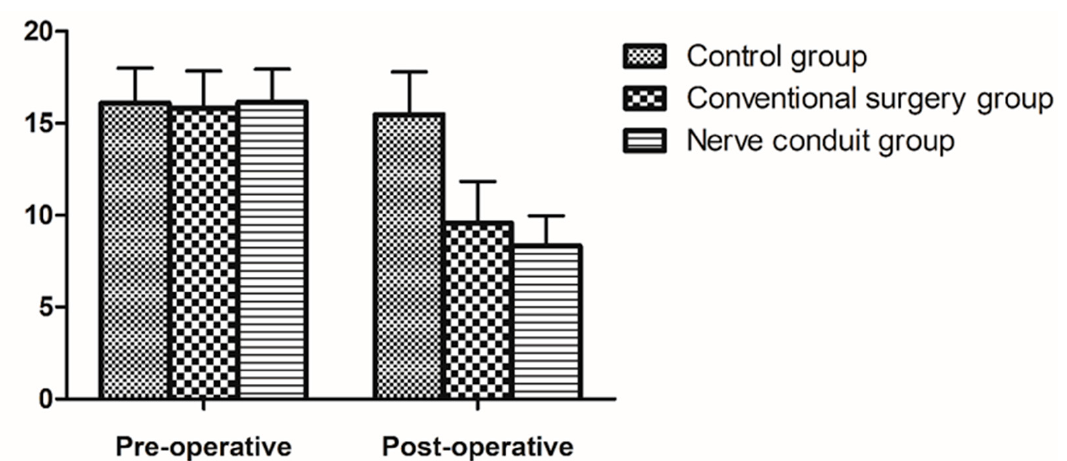
Table 2. Comparison of the curative e ff ect among the three groups [n (%)].